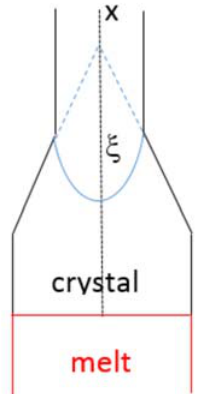
Figure 8. Schematic diagram showing the geometry considered by Louchev et al. [54].